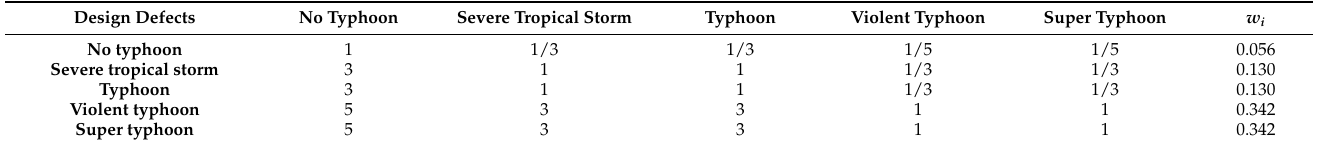
Table 12. Important degree judgment matrix for design defects under different typhoon